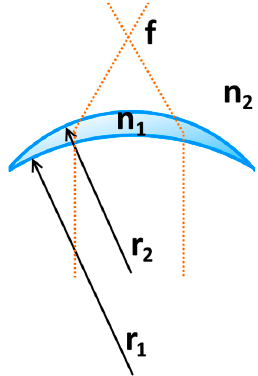
Figure 5. Simple lens with a positive meniscus and focal power, with notation that corresponds to the equation for a lens (Equation (3)).